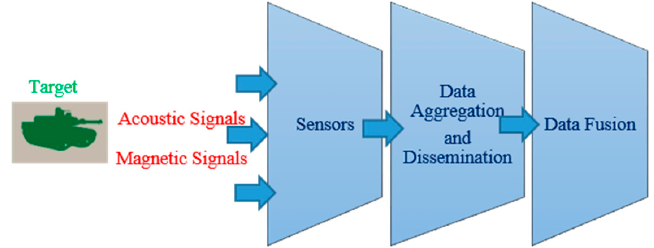
Figure 5. Illustration of the system architecture proposed in [6] for target tracking.